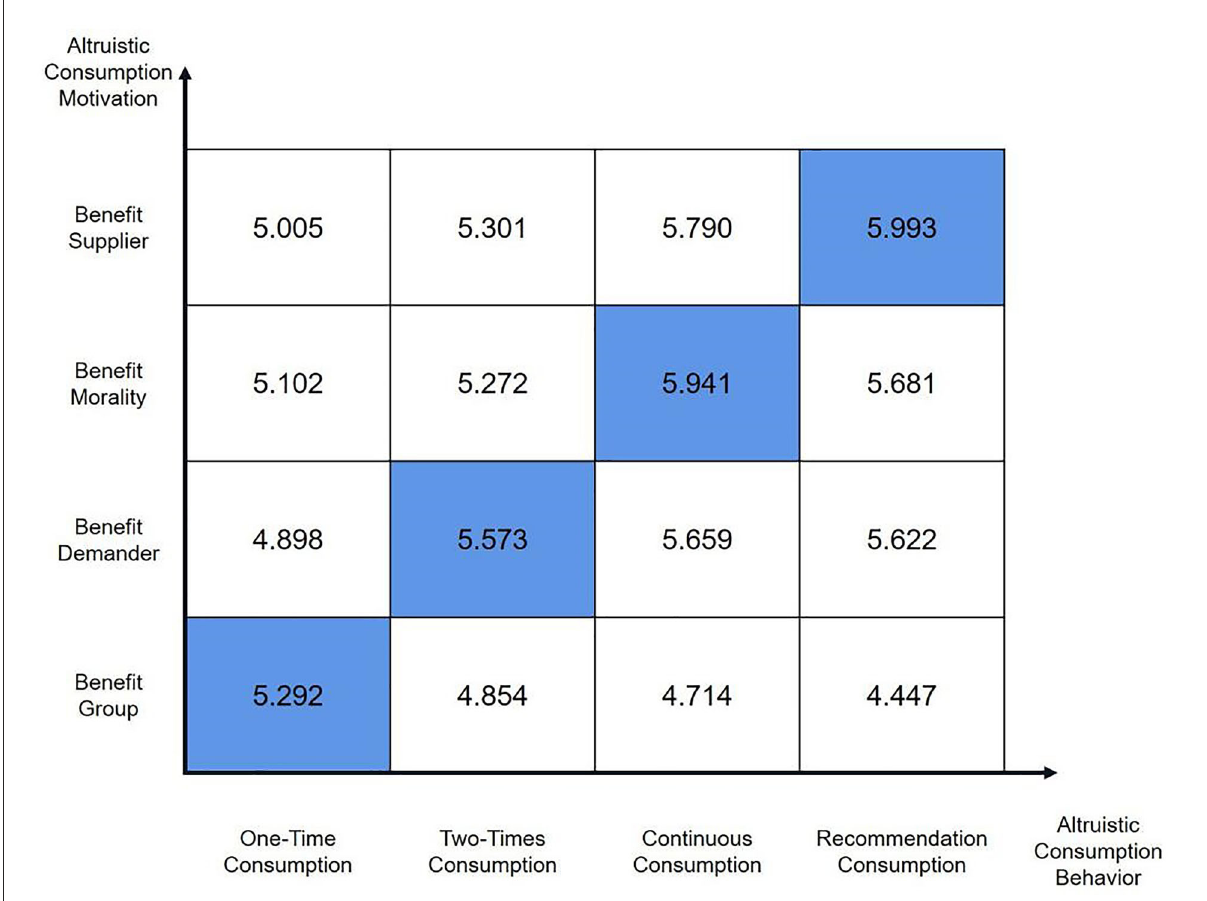
FIGURE1 Data matrix of altruistic consumption motivation and altruistic consumption